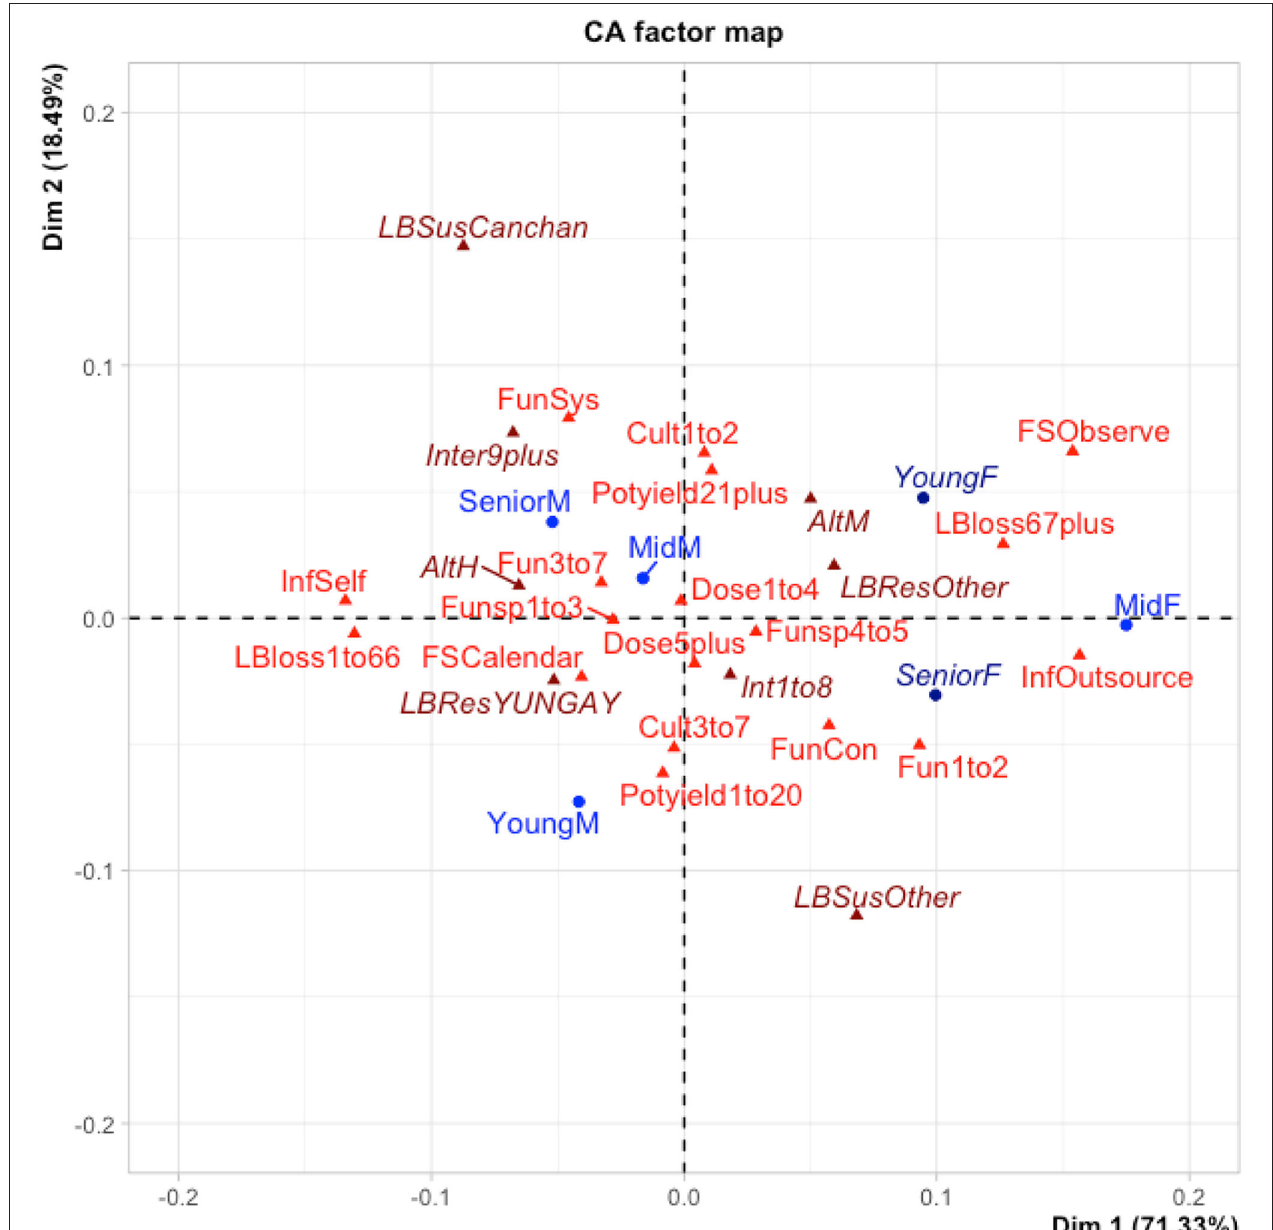
FIGURE 8 | Correspondence analysis biplot for characteristics and responses of respondents from Ulcumayo. Color code: dark blue, respondent age-gender classes that form the rows in the contingency table; light blue, respondent age-gender classes used as supplementary rows; red, management choices in the form of discretized variables that form the columns in the contingency table; brown, management choices used as supplementary